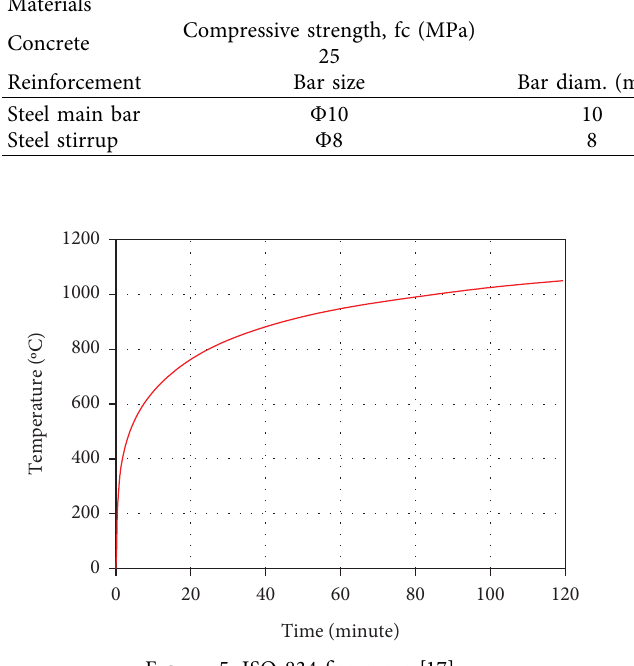
Figure 5: ISO-834 fre curve [17].